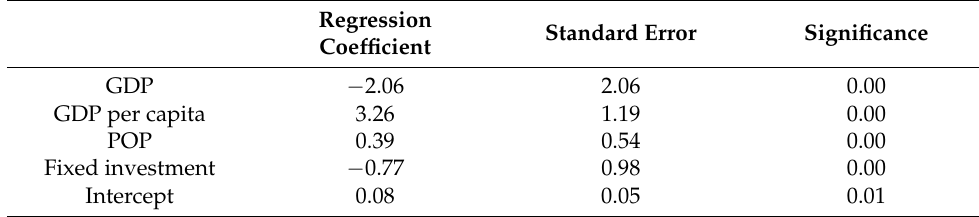
Table 3. Regression